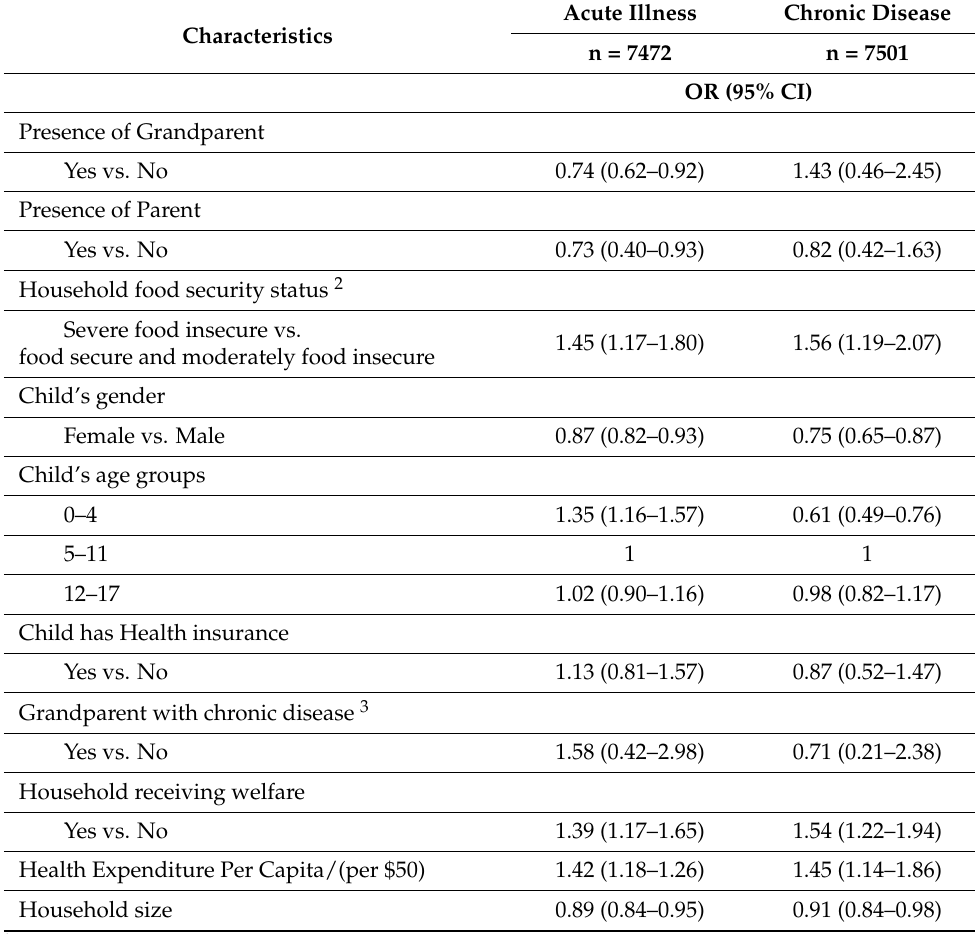
Table 4. Multivariate logistic regressions of factors associated with child’s health (0–17 years) (2010 and 2015 Socio-Economic Surveys of Palestinian Refugees in Lebanon). 1 .